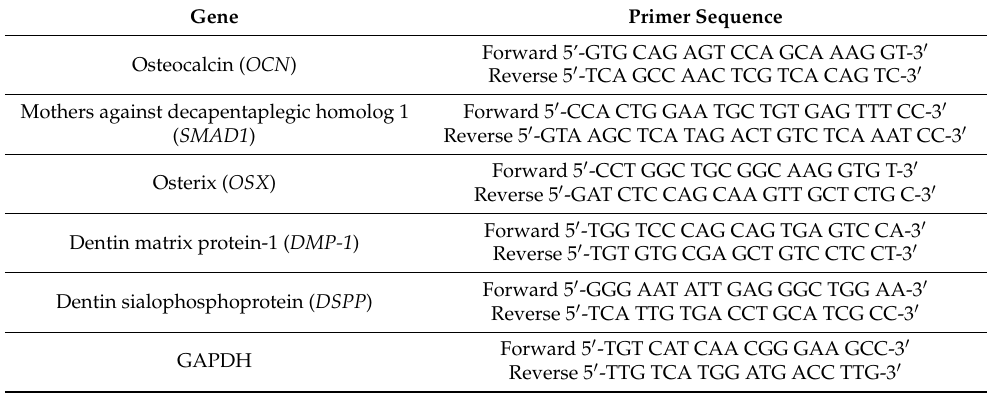
Table 2. Primer sequences for evaluating osteogenic gene expression in hBMSCs.